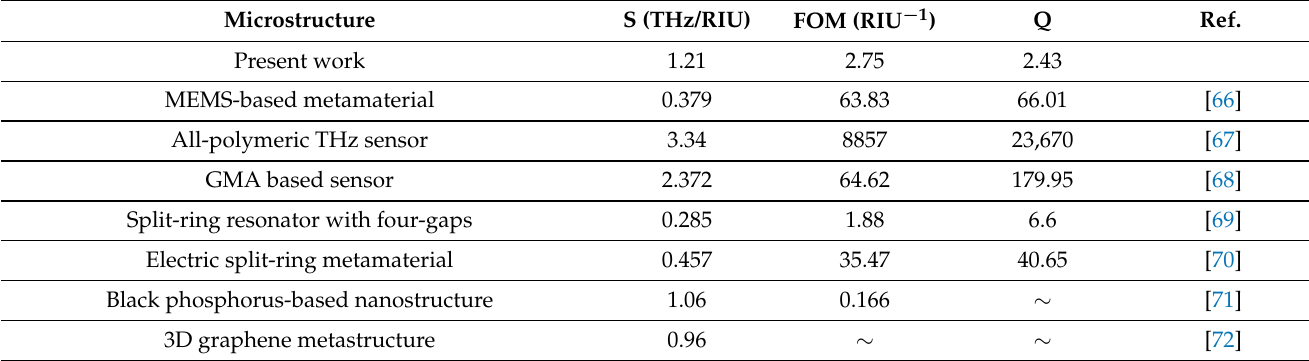
Table 2. Parametric comparison of the reported THz metamaterials or